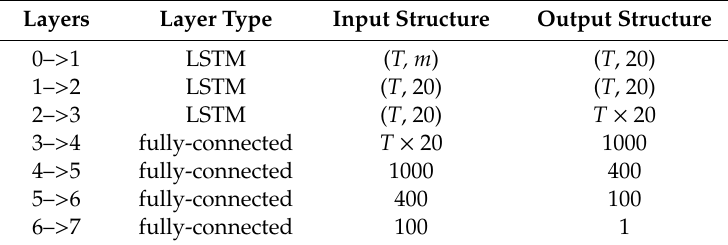
Table 3. The architecture of LSTM with daily input data.